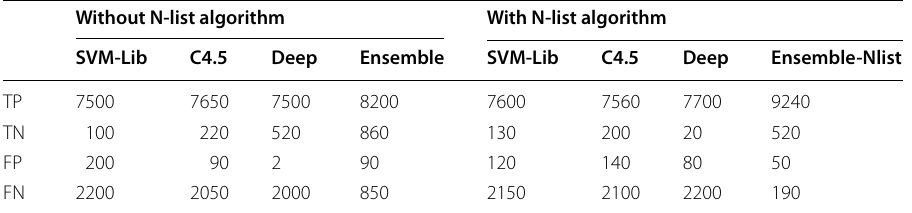
Table 12 TP, TN, FP and FN results of the SVM-Lib, C4.5 and deep neural network algorithm for basket analysis with and without the N-LIST algorithm